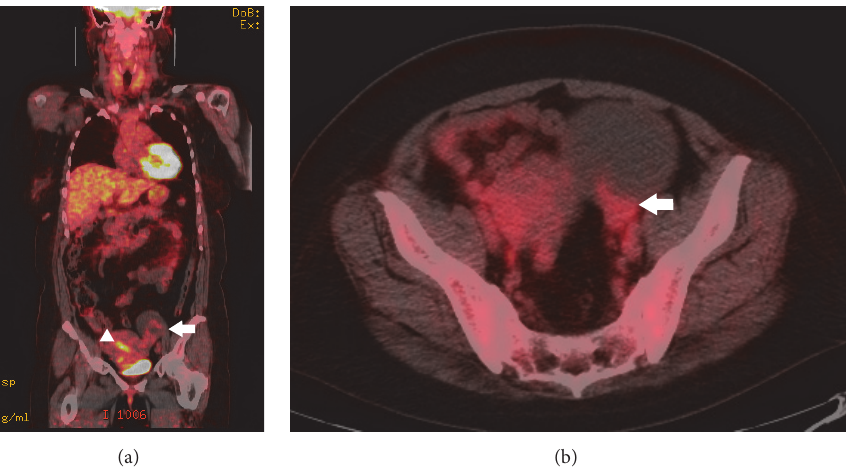
Figure 2: Fluorodeoxyglucose-positron emission tomography findings. Fused coronal (a) and transverse (b) images, demonstrating a maximum standardized uptake value of 2.9 in the ovarian mature cystic teratoma (arrow) (white arrowhead =